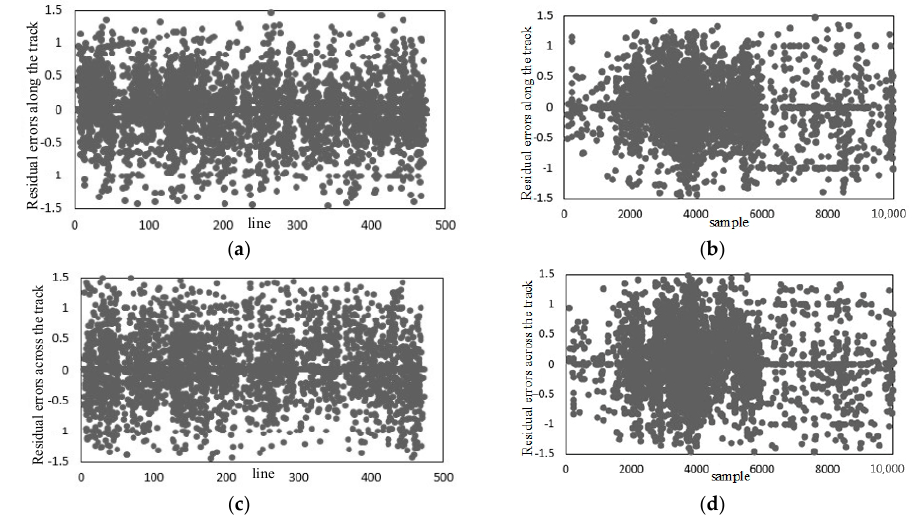
Figure 11. Residual errors after internal calibration: ( a ) Residual errors along the track (flight direction); ( b ) residual errors across the track (flight direction); ( c ) residual errors along the track (whiskbroom direction); ( d ) residual errors across the track (whiskbroom direction).